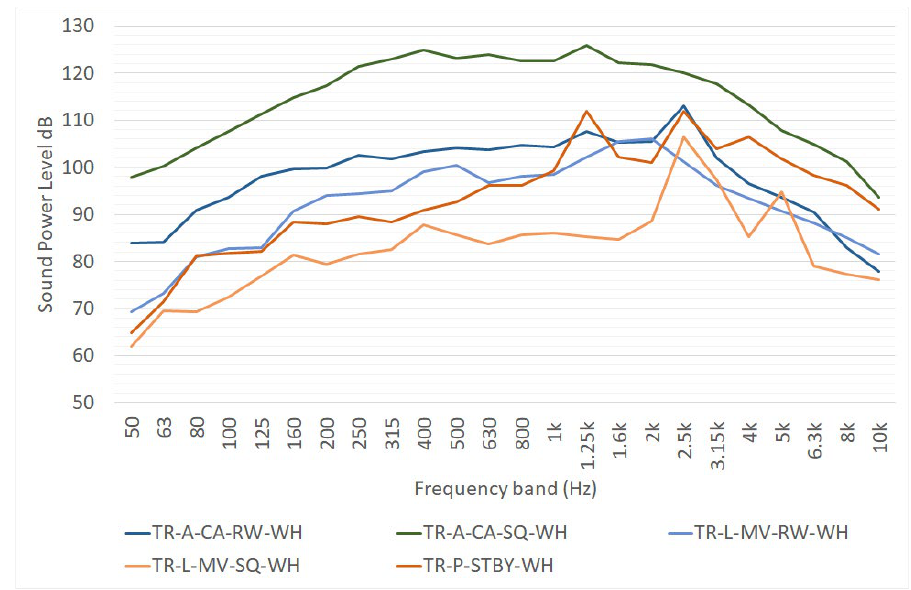
Figure 1. One-third octave sound power level spectra of a transtainer, as reported in [16]. L W is expressed in dB for point sources, in dB/m for linear sources and in dB/m 2 for area sources.